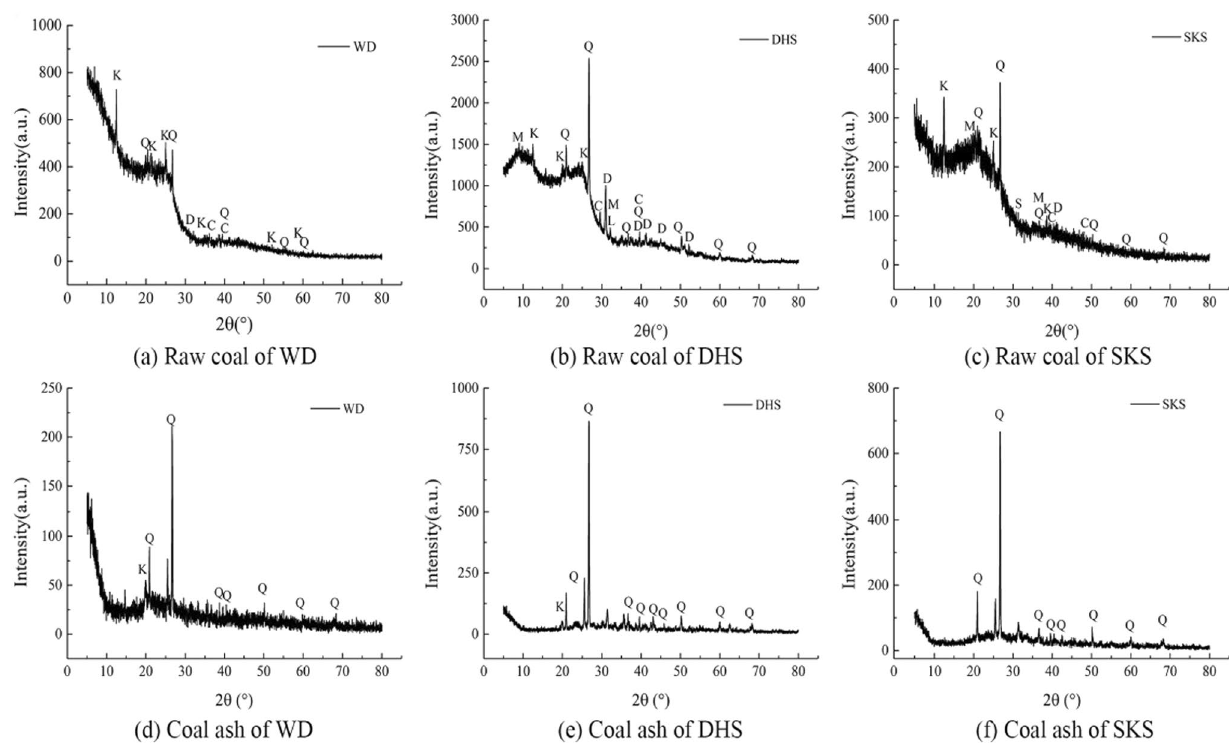
Fig. 5 X-ray diffraction patterns for raw coal ( a – c ) and coal ash ( d – f ). Q, Quartz; K, Kaolinite; D, Dolomite; C, Calcite; L, Lime; S, Siderite; M, Muscovite Fig. 6 Infrared spectra for dif- ferent coal samples with particle sizes of 0.15–0.18